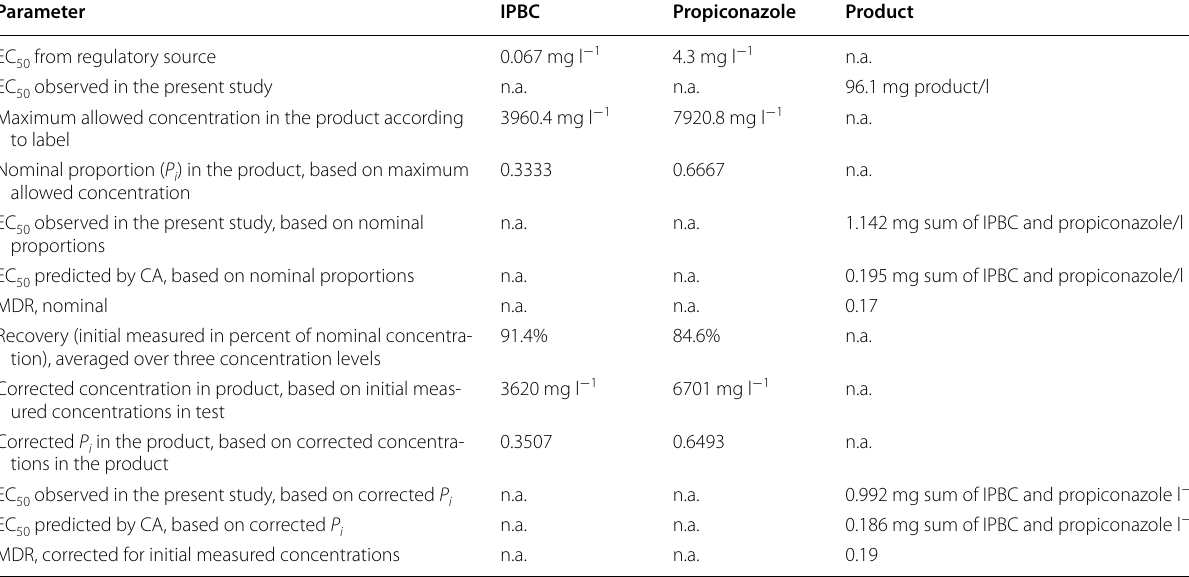
values considering 50